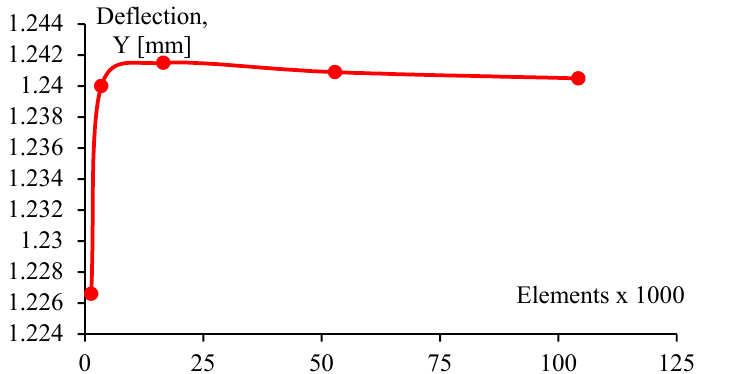
Figure 10. Exemplary convergence for vertical deflection values for the numerical simulation.